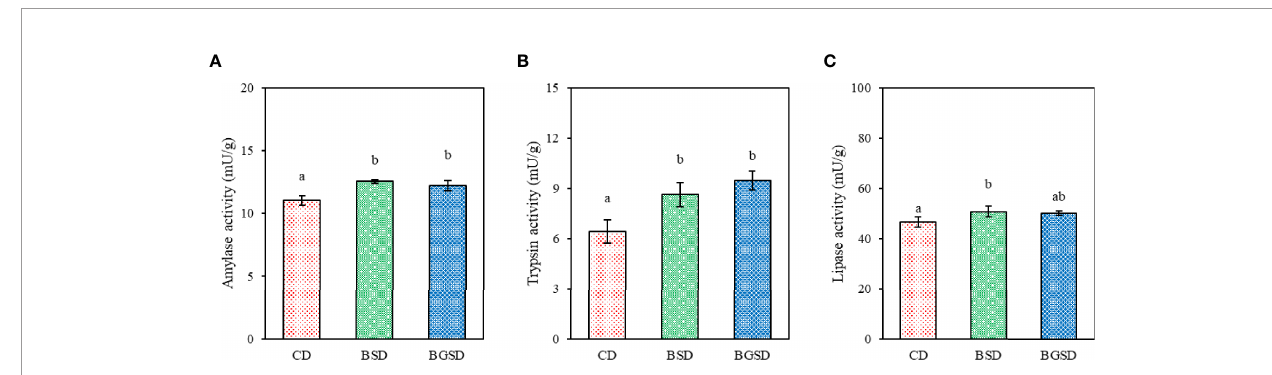
FIGURE 1 | Comparison of the measured amylase (A) , trypsin (B) , and lipase (C) activities between the three groups. The data represent the mean ± standard deviation; different letters indicate statistically signi fi cant differences between groups ( P < 0.05). Control diet, CD: without Bacillus sp. PM8313 or b -glucan, BSD: 1 × 10 8 CFU g − 1 Bacillus sp. PM8313, and BGSD: BSD + 0.1% b -glucan.